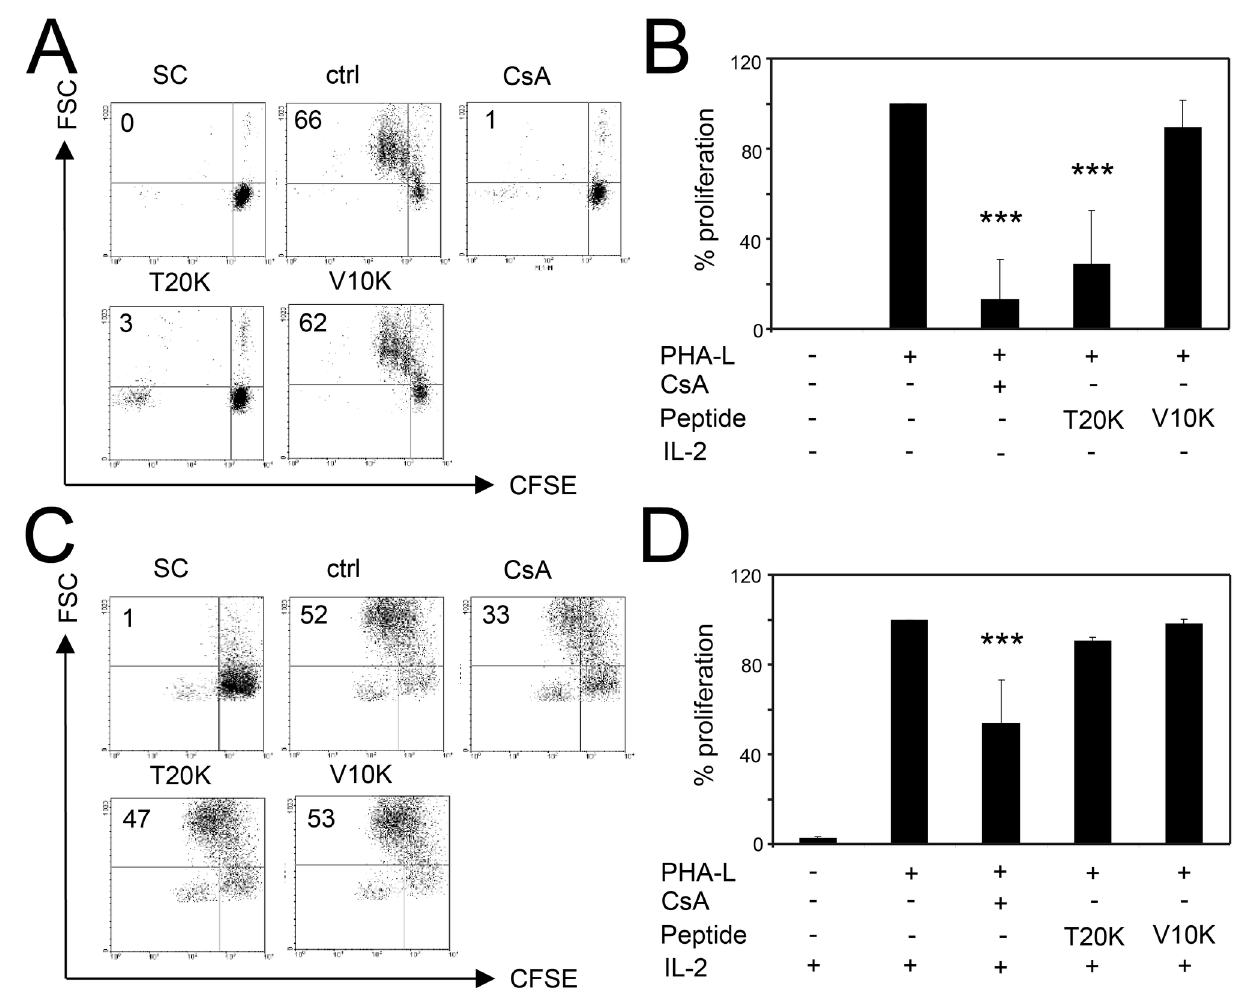
Figure 4. Effects of exogenous IL-2 on proliferation capacity of cyclotide-treated lymphocytes. CFSE-labeled primary human lymphocytes were pretreated with CsA or cyclotides (4 µM each) and were activated using PHA-L (10 µg/mL), followed by washing off the cyclotides and activation stimuli. Furthermore, the cells were cultured without ( A and B ) or in the presence of exogenous recombinant human IL-2 ( C and D ). The proliferation capacity of the cells was analyzed at day three by flow cytometry. Representative data are presented in dot plots ( A and B ) and summary of three independent experiments were presented as mean ± SD ( B and D ). The values in dot plots represents the amount of proliferated lymphocytes on which the quantification to control is based. The asterisks represent significant differences of treated cells in comparison to ctrl (PHA-L stimulated cells alone) (* P <0.05, ** P <0.01, *** P